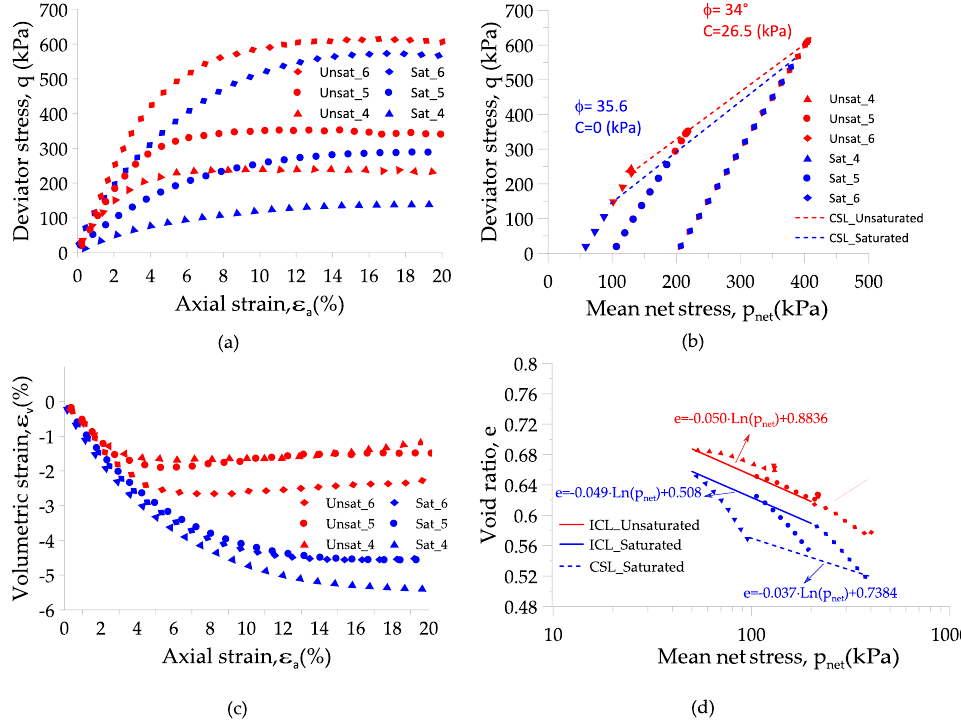
Figure 14. Behavior of the soil studied at a dry unit weight of 17.5 kN/m 3 . ( a ) Diagram of stress versus axial strain (q vs. ε a ). ( b ) Diagram of p net vs. q. ( c ) Volumetric strain versus axial strain. ( d ) Diagram of p net vs. void ratio during the shear